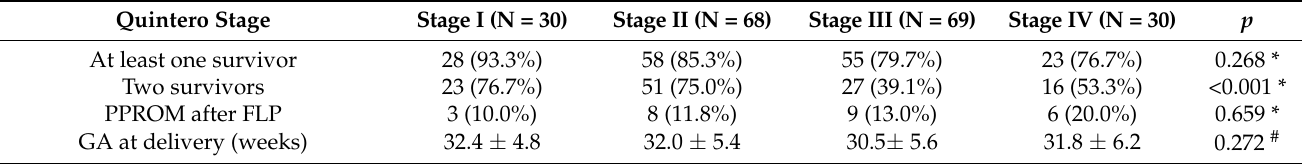
Table 3. Outcomes of TTTS after FLP among different Quintero